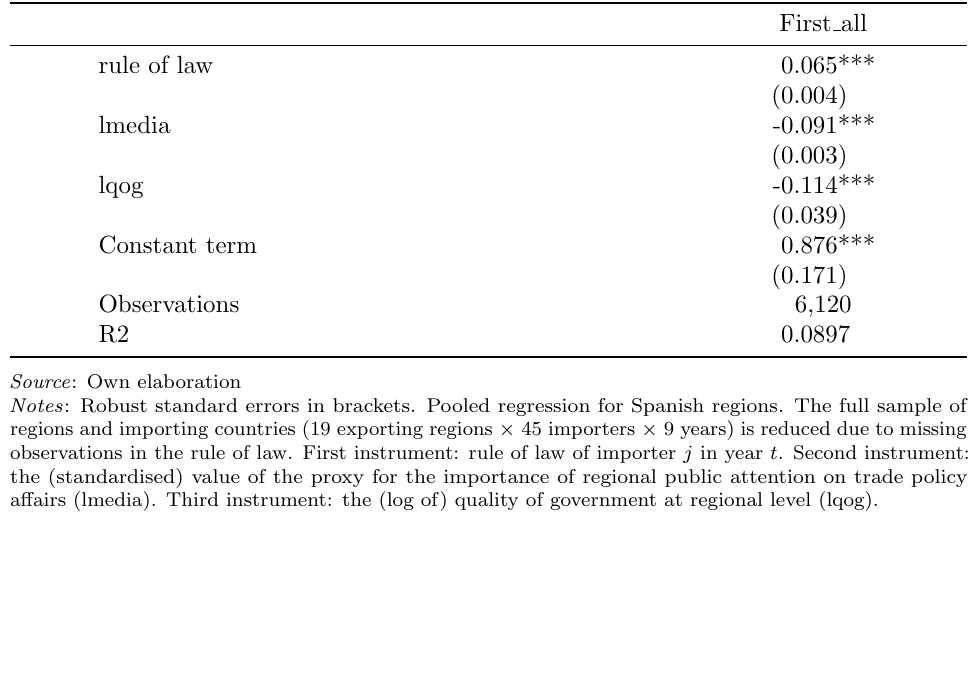
Table A.2: First-stage